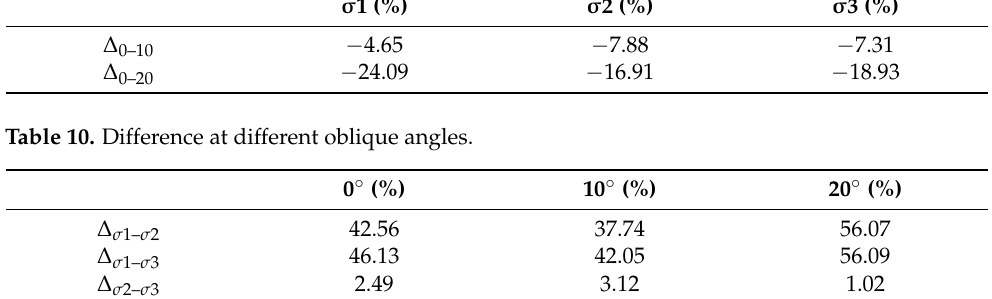
Table 9. Difference at different cavitation numbers.